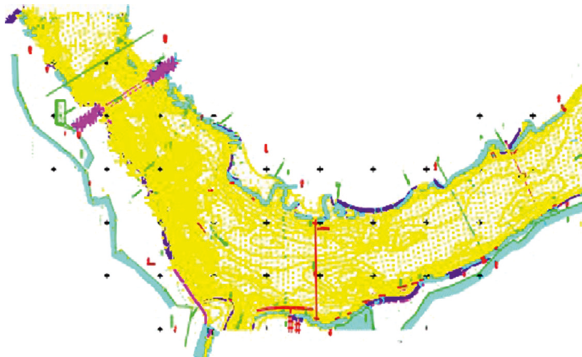
Figure 1: Topographic drawing of the channel.